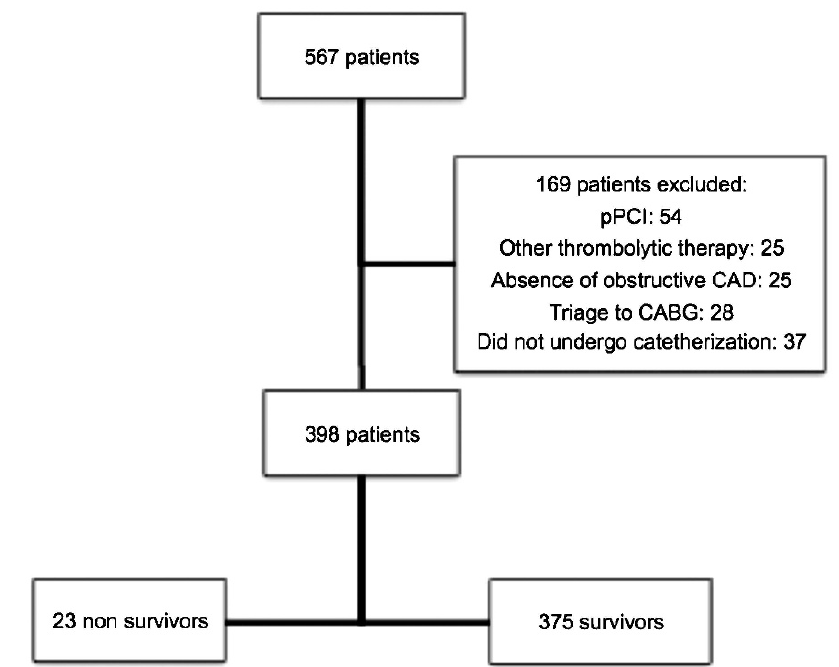
Figure 1 - Flowchart of patients included in